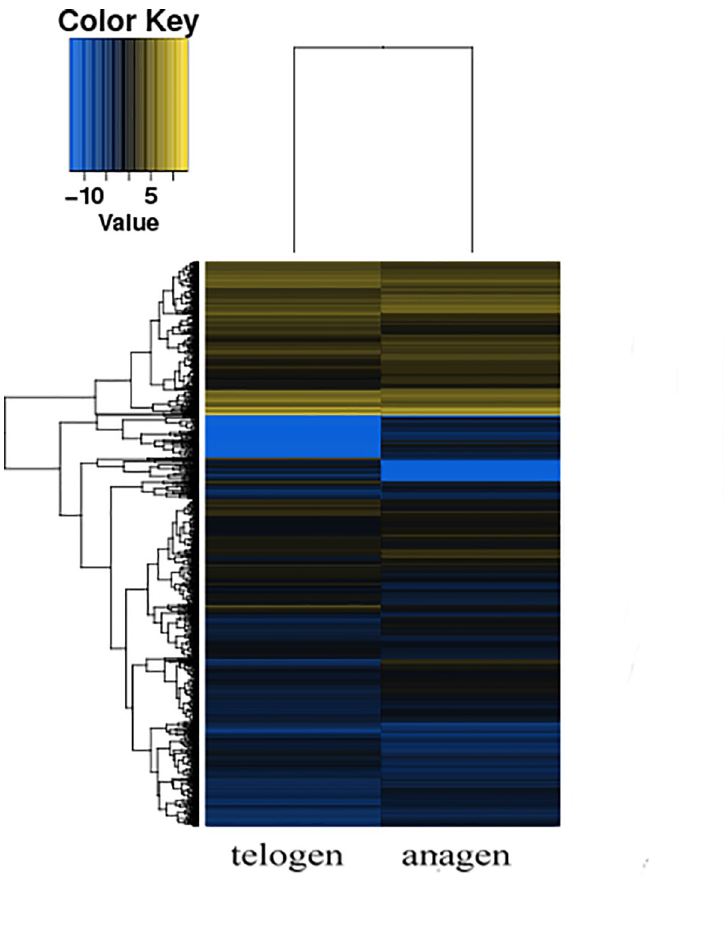
Fig 3. Hierarchical cluster analysis of gene expression based on log ratio FPKM data. Yellow indicates the genes with greater expression, and blue indicates the genes with lower expression. There were clusters with relatively minor differences between anagen and telogen secondary